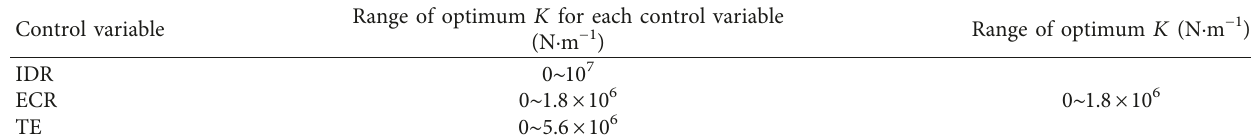
Table 3: C 5 10 5 Ns/m, range of optimum K under earthquake GM1. (cid:29) ×